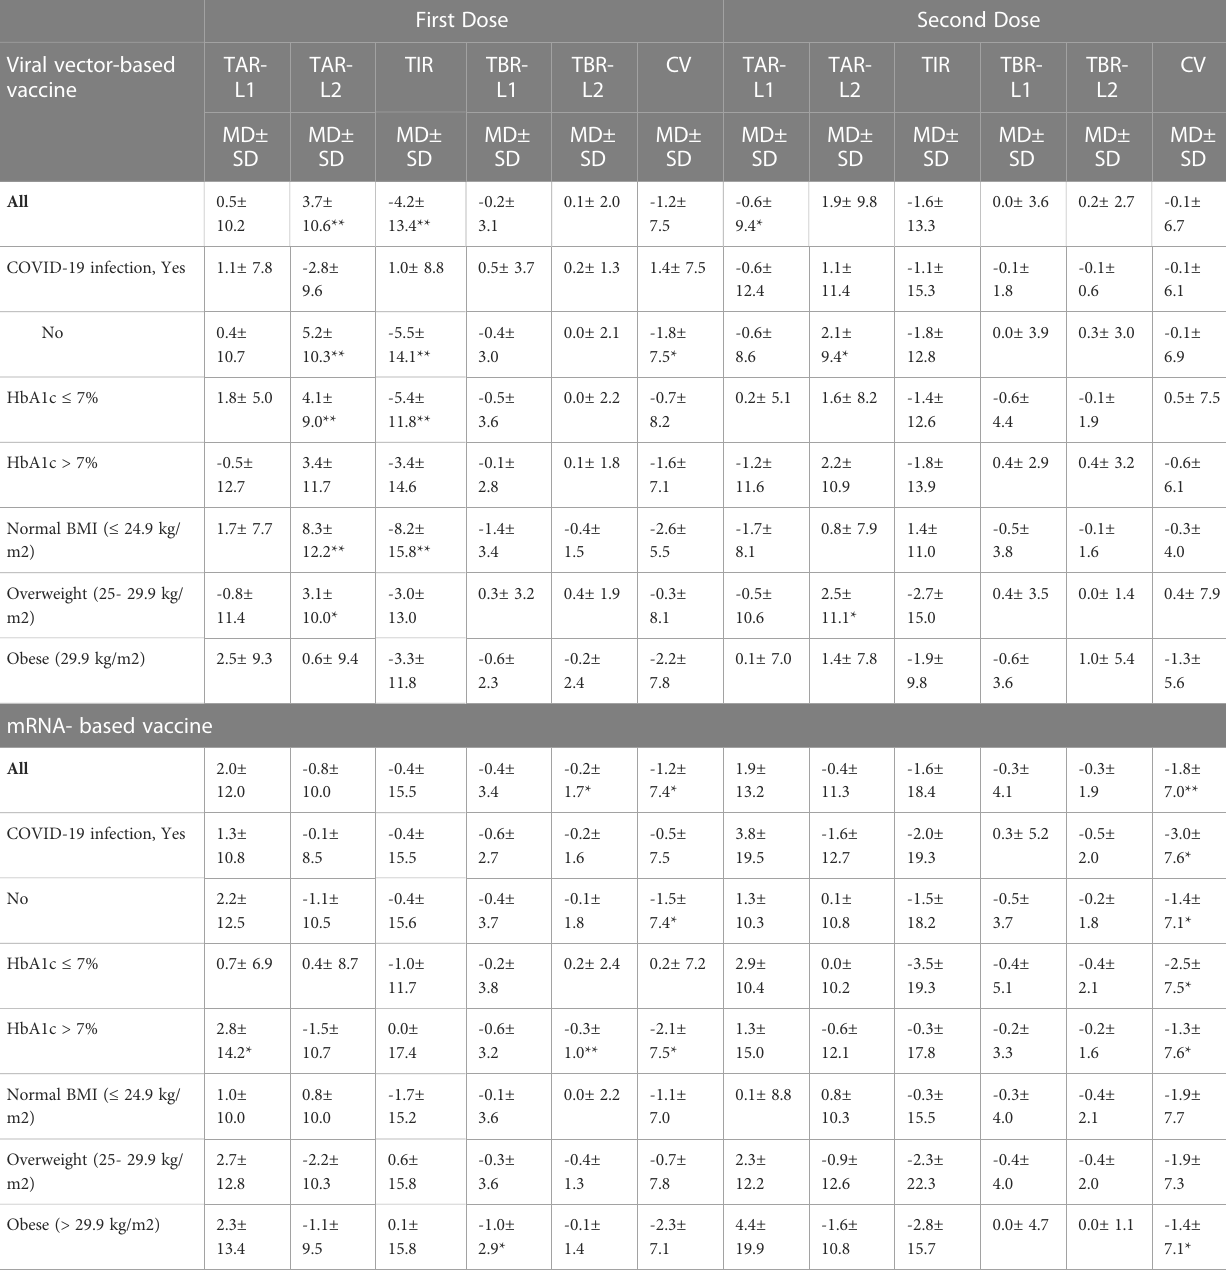
TABLE 3 Changes in glucose metrics (%) after 7 days of viral vector-based and mRNA-based COVID-19 vaccine in people with type 1